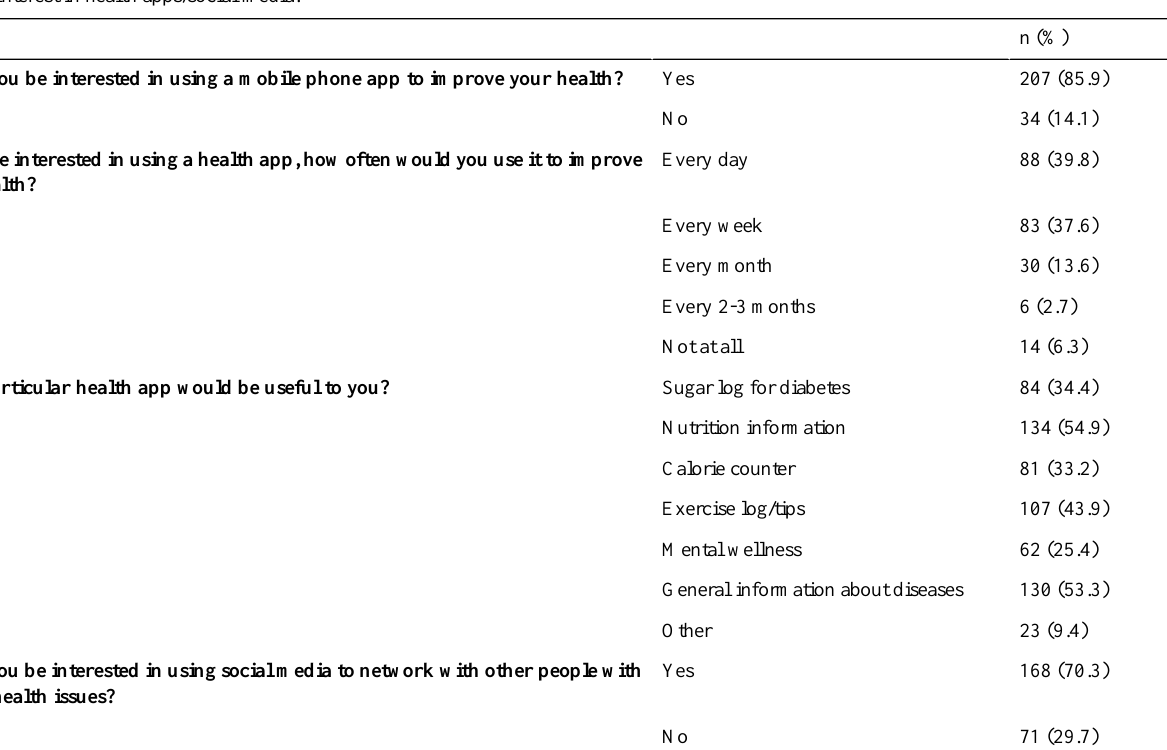
Table 3. Interest in health apps/social